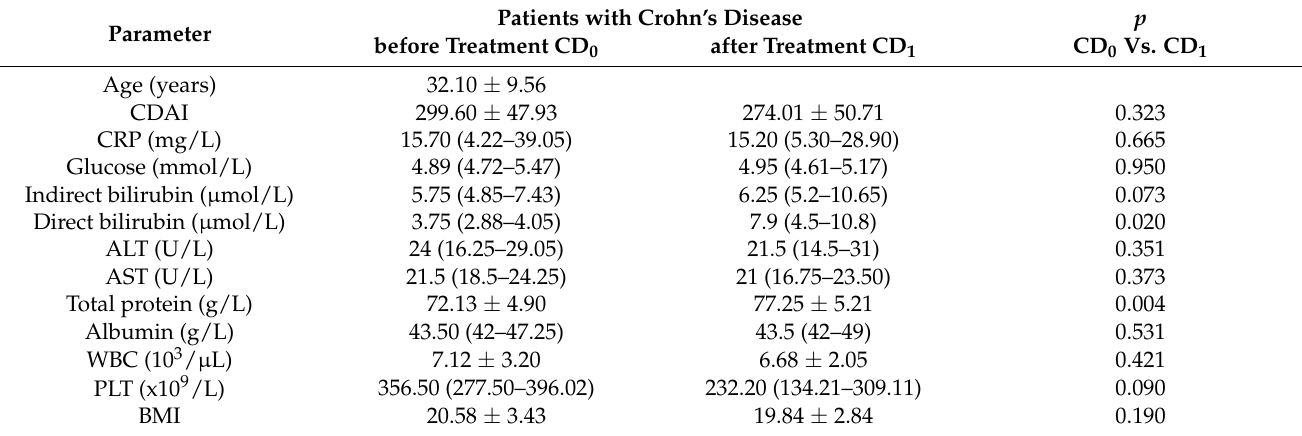
Table 2. Clinical characteristics of patients with Crohn’s disease